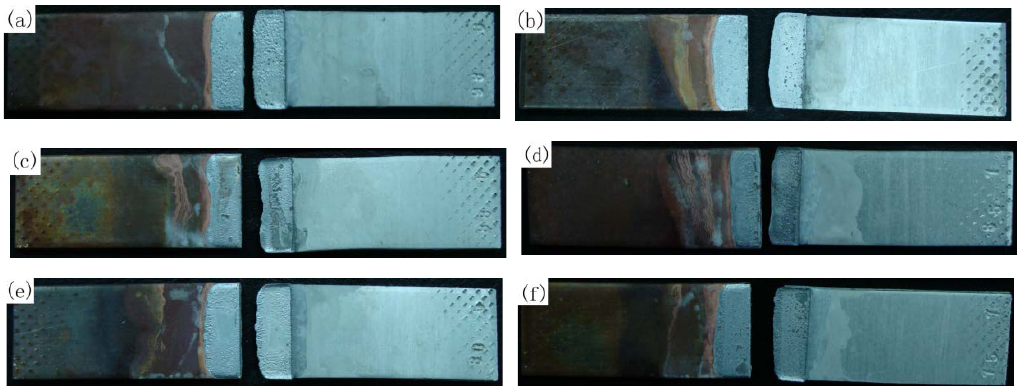
Figure 4. Macro fracture surfaces of 3003 Al/Cu joint brazed by ( a ) Zn-2Al; ( b ) Zn-5Al; ( c ) Zn-12Al; ( d ) Zn-15Al; ( e ) Zn-20Al; and ( f ) Zn-25Al.